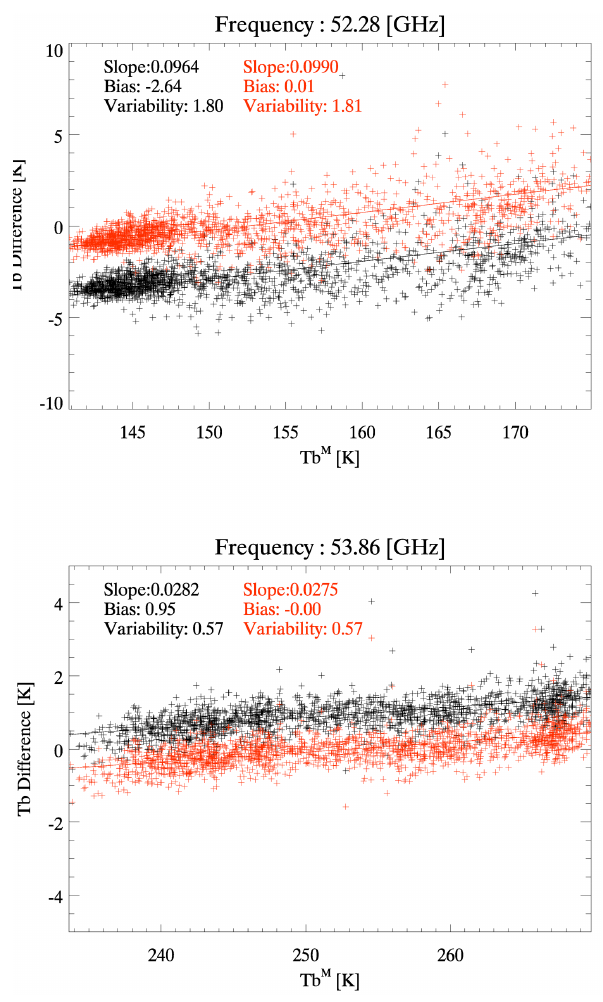
Figure 6. The T b difference as a function of T M (black crosses: b − T E − T new ) for the data set obtained af- T M , red crosses: T M b b b ter removing data with faulty calibration and data contaminated by clouds. The solid lines are the best linear